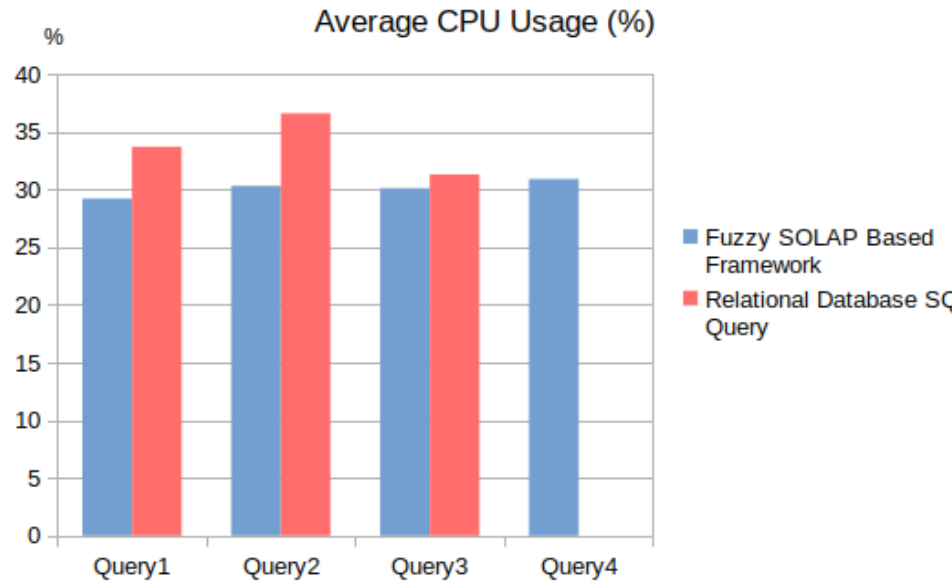
Figure 21. Average CPU usages of FSOLAP and relational database SQL queries.